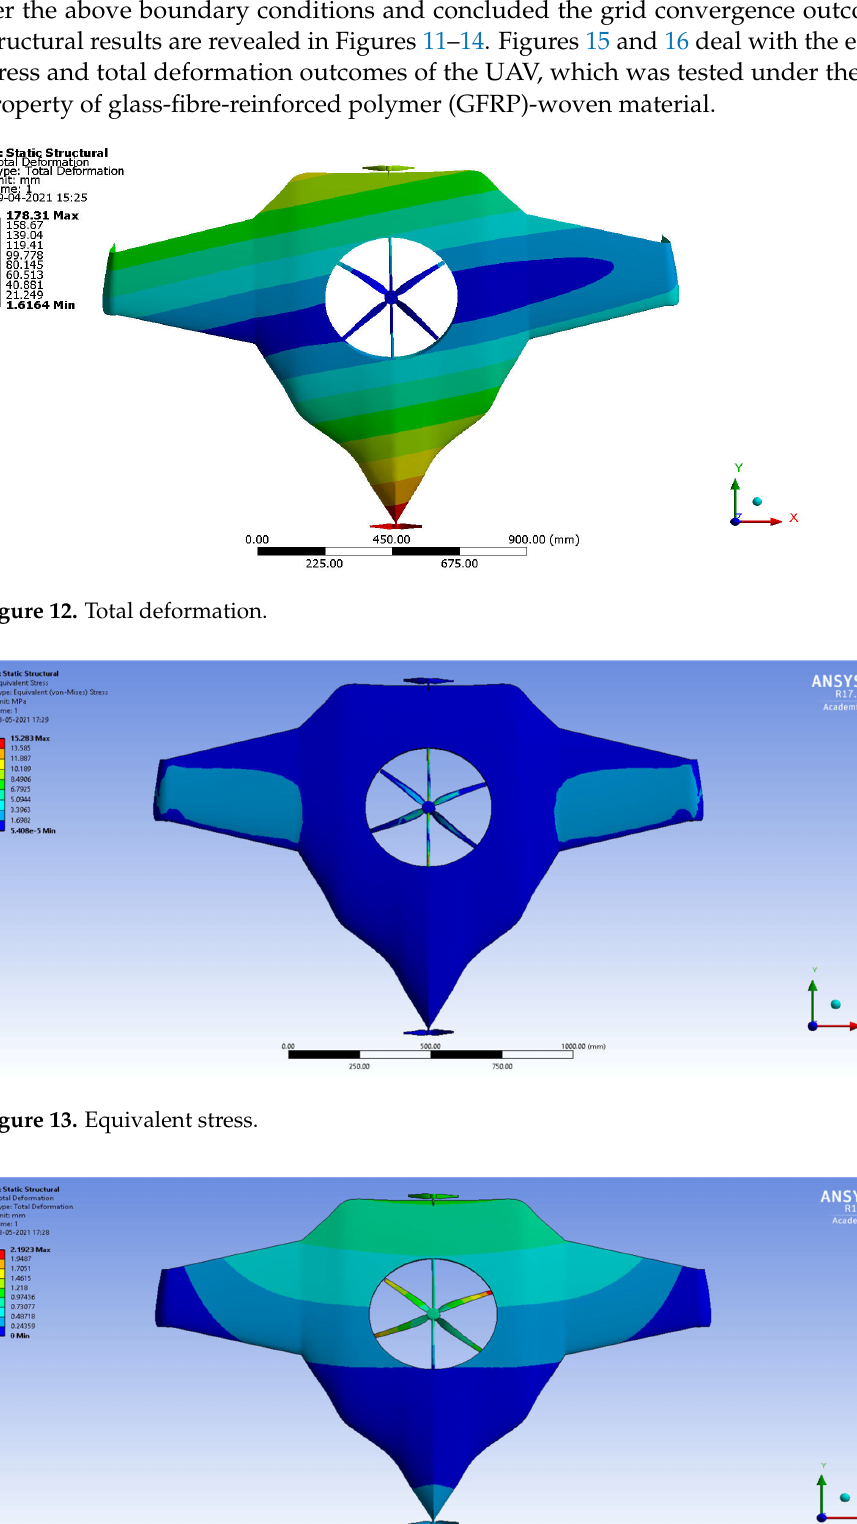
Figure 14. Total deformation.